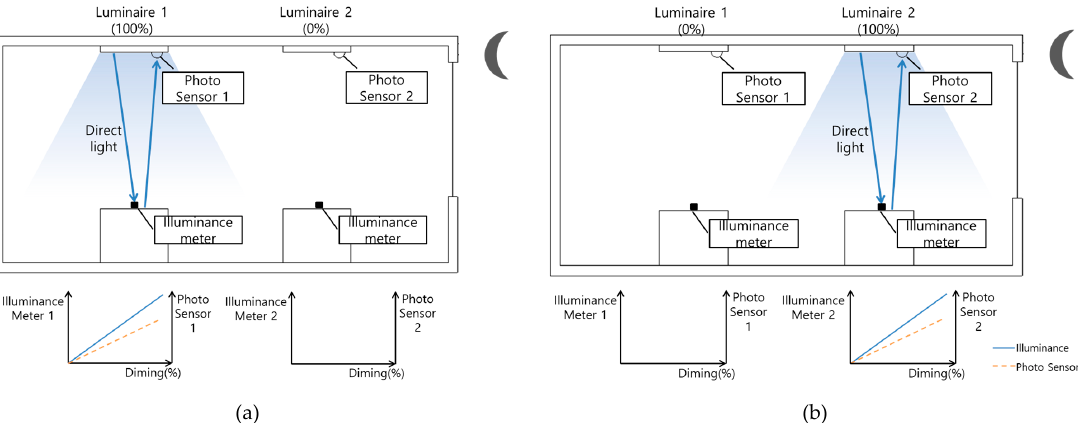
Figure 3. System processes of simple commissioning: ( a ) learning process for luminaire 1; ( b ) learning process for luminaire 2.